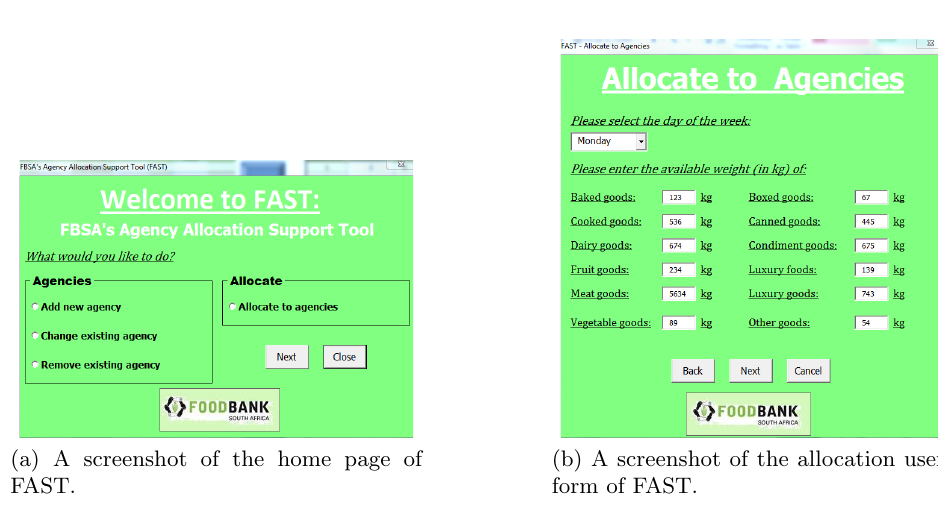
Figure 3: Userforms of FBSA’s Agency Allocation Support Tool (FAST).